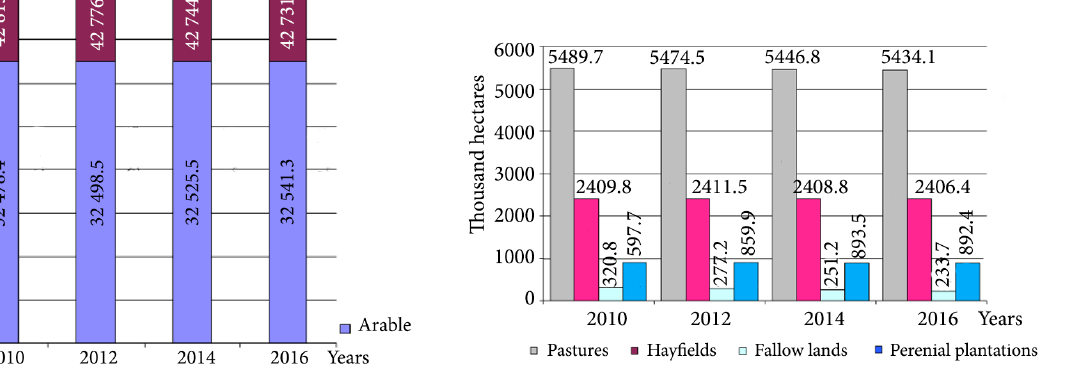
Figure 4. The dynamics of changes in the areas of agricultural land and arable land in their composition in 2010–2016